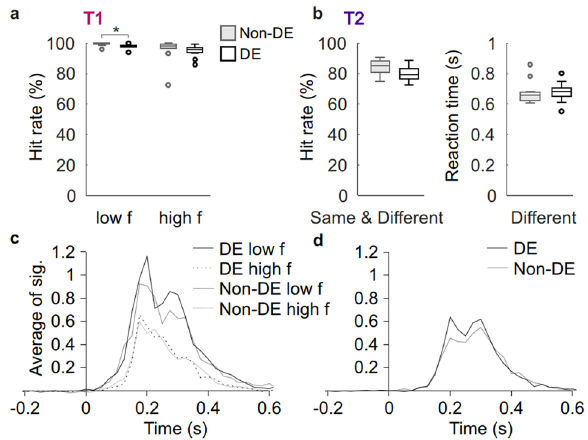
Figure 4. Performance and ERs for control participants. ( a ) HRs for the DE and Non-DE in T1. Stars mark significant difference ( t -test, p < 0.05). ( b ) HRs and RTs in T2. Note that if the stimuli is “Same”, the participant is to withhold using the response pad. ( c ) ERs in T1 and ( d ) in T2. Axes and scales as in Fig. 2. In boxplots median is marked with a line, and the whiskers extend at maximum to 1 × the interquartile